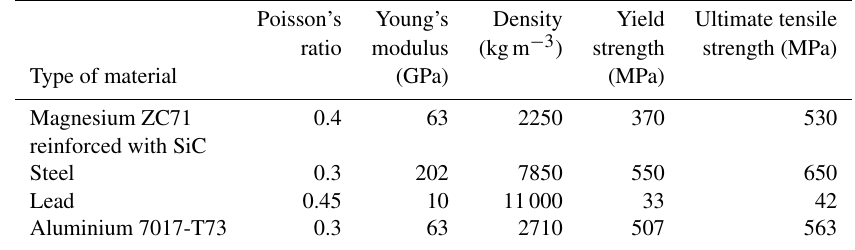
Table 1. Properties of the ZC71 magnesium alloy reinforced with SiC compared with steel, lead, and aluminium 7017-T73. Poisson’s